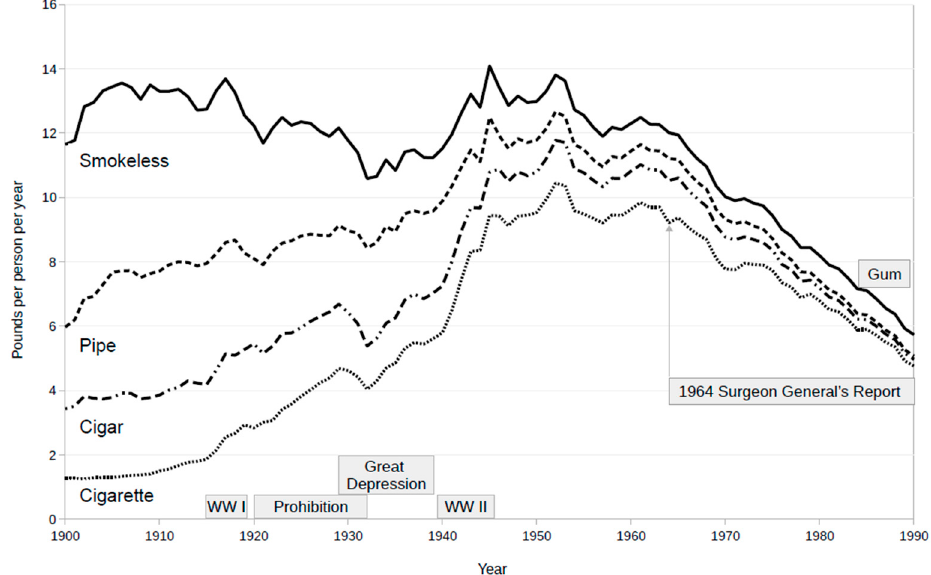
Figure 1. Annual cumulative tobacco product consumption in the USA. Tobacco product sales in pounds per person per year are shown from 1900 to 1990. Derived from Psoter 2001 [4]. The bottom curve represents cigarette tobacco sales. Market share of cigar, pipe and other loose tobacco, and smokeless tobacco products are vertically stacked, so that the solid top line represents total tobacco sales. Nicotine replacement products and electronic cigarettes are not represented. Prescription nicotine gum sales began in 1984 at a rate of $40 million/year, and clearly began to displace tobacco products [5]. WWI is World War I. WWII is World War II. Prohibition was a period when ethanol was illegal to sell for drinking.